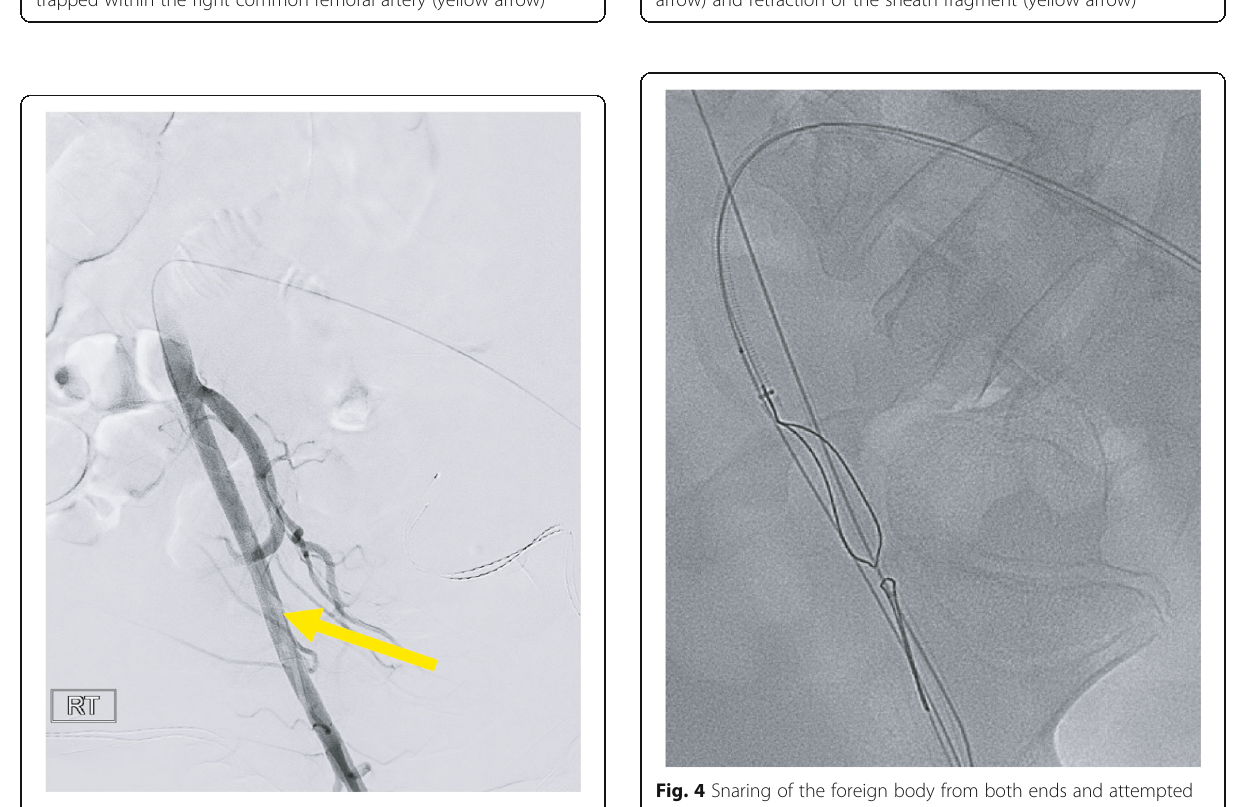
Fig. 2 Snapshot from digital subtraction angiogram (DSA), clearly demonstrating intravascular position of the sheath